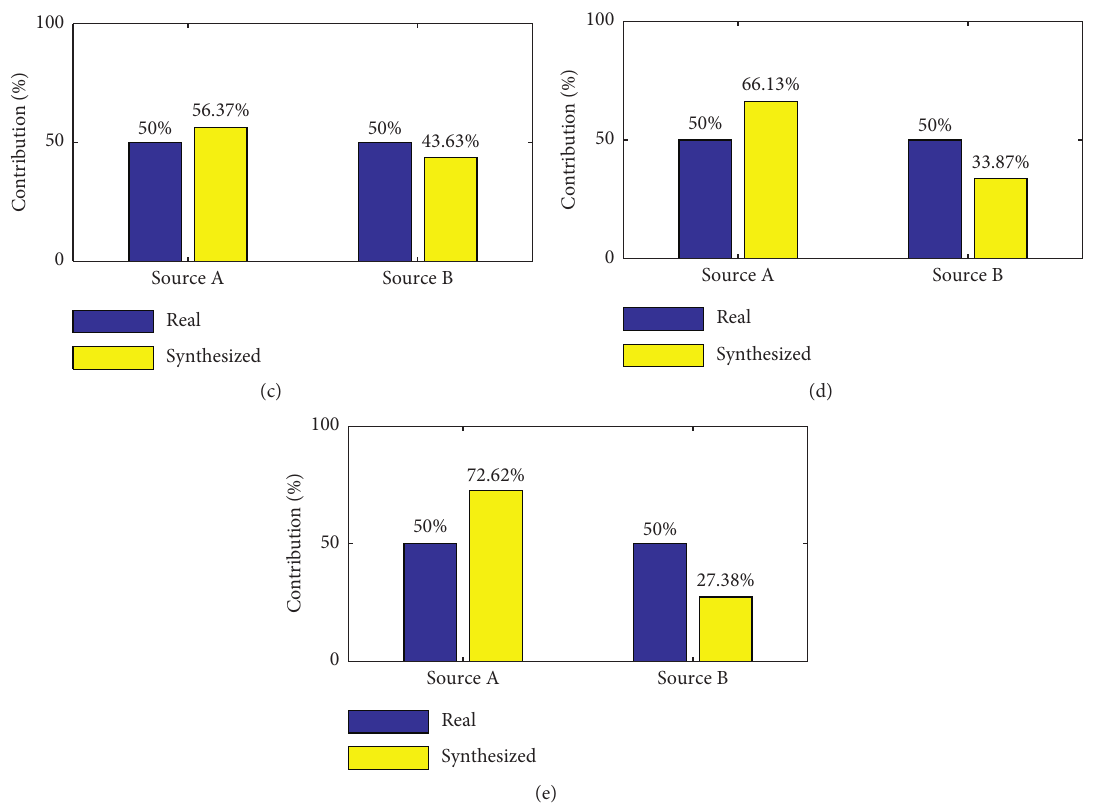
Figure 16: Contribution percentage of each source in function of the correlation factor: (a) correlation � 20%; (b) correlation � 40%; (c) correlation � 60%; (d) correlation � 80%; (e) correlation � 100%.